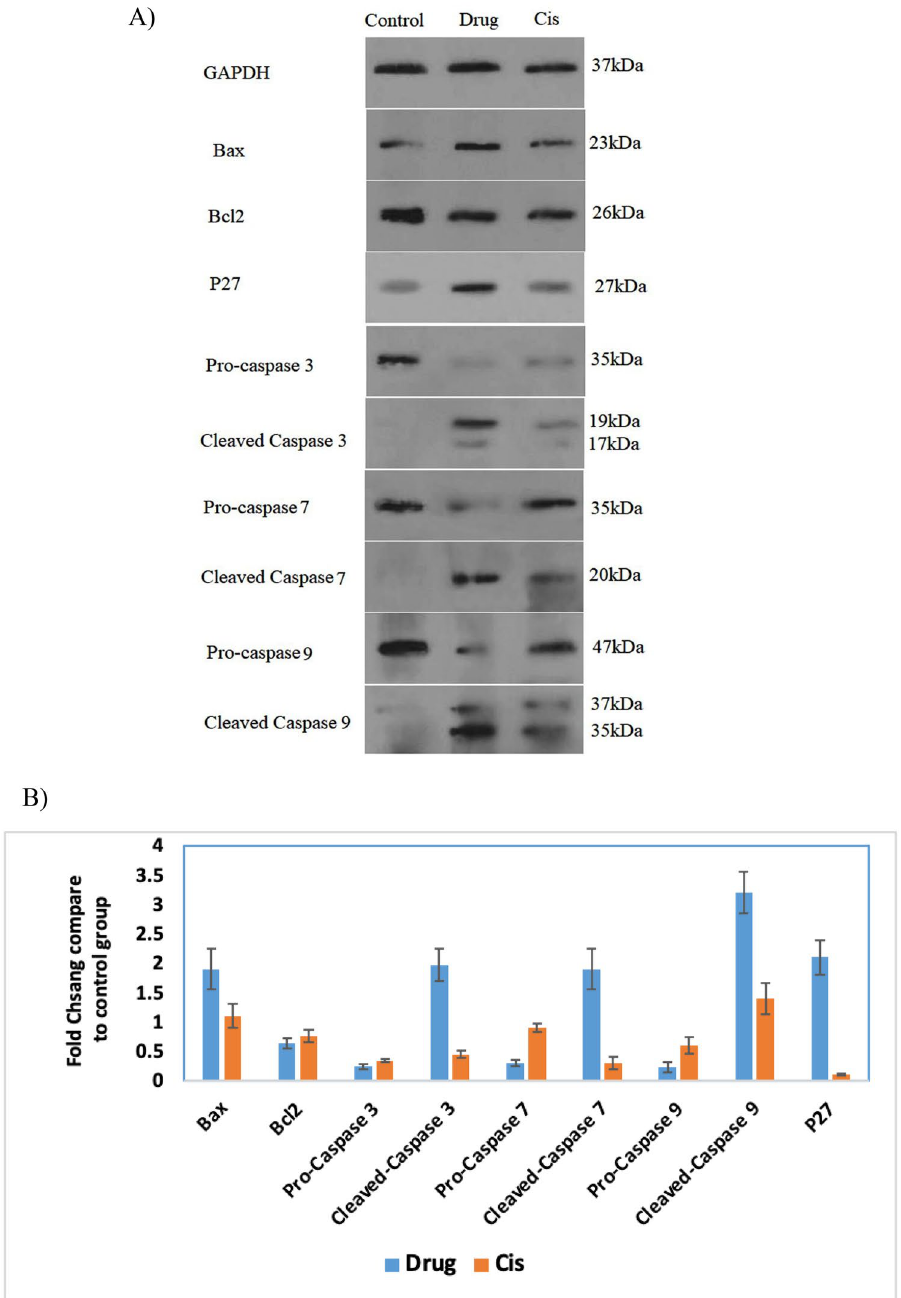
Figure 6. The cropped blots/gels of proteins expression obtained from western blotting of the Caco-2 cells treated with IC 50 value of Cisplatin and Pt(TSC)Cl complex. Un-treated cells were considered as the control group. Proteins: Bcl-2, Bax, p27, pro-Caspase-3, Cleaved-Caspase-3, pro-Caspase-7, Cleaved-Caspase-7, pro-Caspase-9, Cleaved-Caspase-9, and GAPDH as internal control. Full-length blots/gels are presented in Supplementary Fig. S4 B) Quantitative results of apoptotic effects assessed by western blot analysis. Drug: Pt(TSC)Cl complex, Cis: